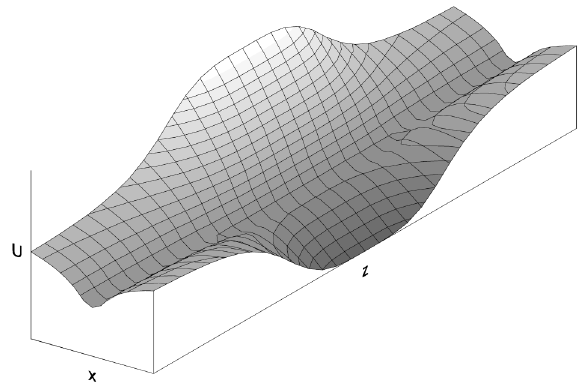
FIG. 10. Cleaning electrodes with low conductive insertions. Dashed lines show trajectories of trapped ionization